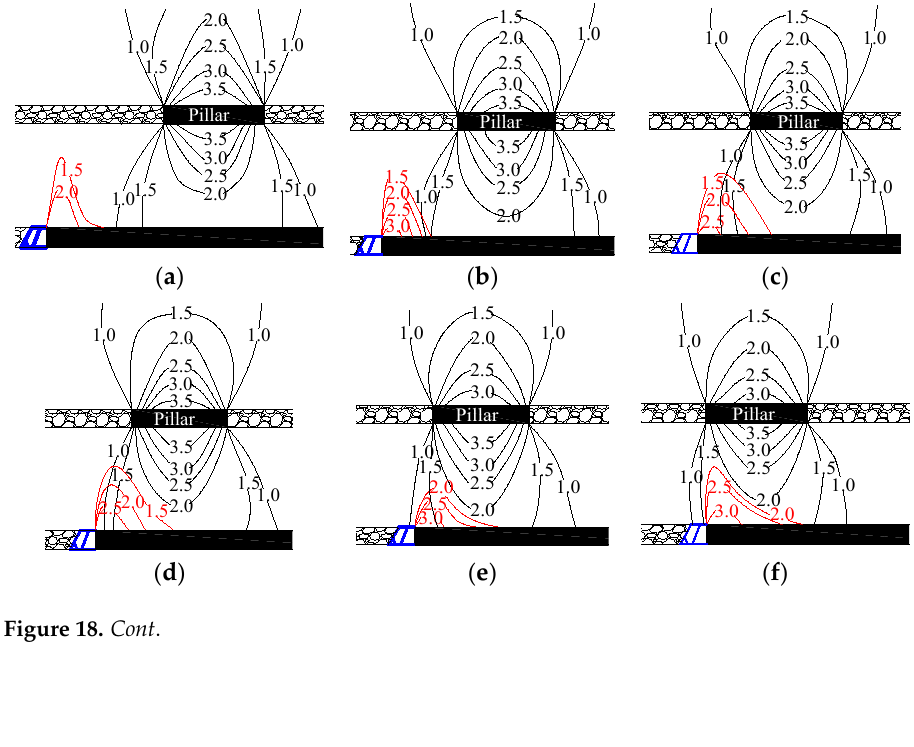
Figure 17. Variation of interburden and pillar stress and FAP by passing coal pillar: ( a ) 25 m before the coal pillar ( − 25 m), ( b ) 15 m before the coal pillar ( − 15 m), ( c ) 0 m into the coal pillar (0 m), ( d ) 10 m into the coal pillar (10 m), and ( e ) 20 m into the coal pillar (20 m). According to the numerical analysis results, it is concluded that the concentrated stress of the coal pillar will be borne by the advanced coal wall and the roof structure above the support in the process of mining. In different stages of the coal pillar, the con- centrated stress of the coal pillar is mainly transferred from the interburden in front of the coal wall and gradually transformed into the roof structure behind the coal wall. That is, there is a dynamic transformation process between FAP and the concentrated stress of the coal pillar, and results are shown in Figure 18.